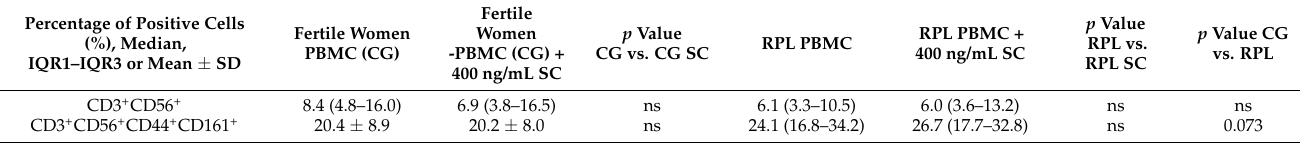
Table 3. Differences in the percentage of CD3 + CD56 + CD44 + CD161 + cells among CD3 + CD56 + cells in the PBMC cultures of healthy women and RPL patients, presented as the mean and SD, in case of the normal distribution of data mean and ± SD, or in case of the non-normal distribution of data, median and IQR1-IQR3 (CG—control group, n = 20; RPL—study group, n = 22; SC—sildenafil